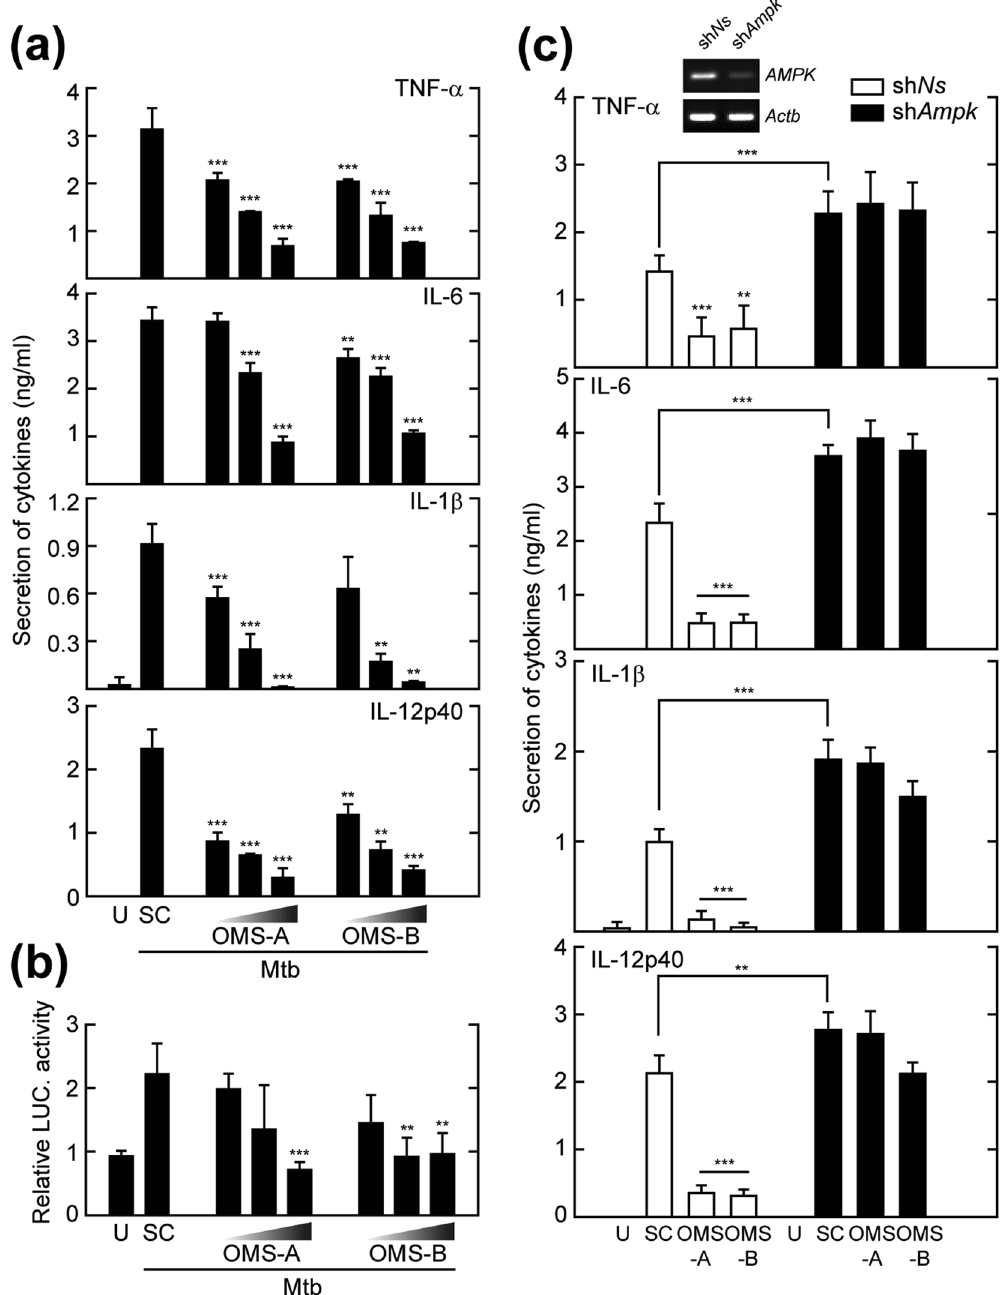
Figure 6. OMS inhibits Mtb-induced inflammatory responses through AMPK activation. ( a ) BMDMs were infected with Mtb (moi = 10) for 4 h and then treated with OMS-A (1, 5, 10 μ M) or OMS-B (1, 5, 10 μ M) for 24 h. ( b ) BMDMs were transduced with adenoviral NF-ĸB-luciferase reporter plasmid for 36 h, and infected with Mtb and then treated with OMS-A or OMS-B for 6 h. The cells were harvested and NF-ĸB luciferase reporter activity was determined. ( c ) BMDMs were transduced with non-specific shRNA (sh NS ) or Ampk - specific shRNA (sh Ampk )-expressing lentivirus for 48 h and then infected with Mtb, followed by treatment with OMS-A or OMS-B for 24 h. ( a and c ) The supernatants were harvested and subjected of ELISA analysis of TNF- α , IL-6, IL-1 β , and IL-12p40 production. All data represent the means ± SD of triplicates from each sample. ** p < 0.01, *** p < 0.001, compared with SC ( a – c ). U, uninfected/untreated; SC, solvent control; ns, no